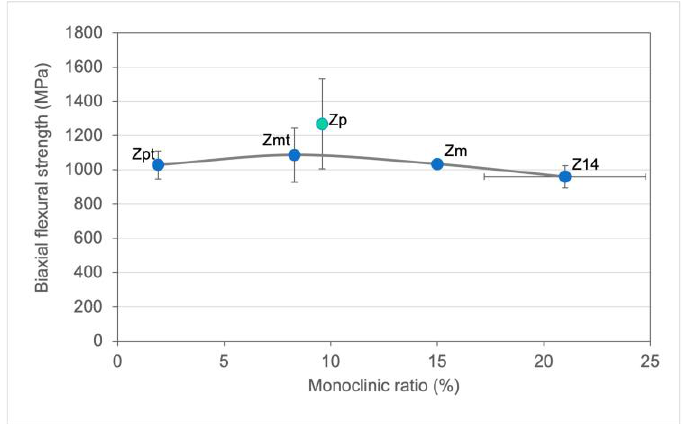
Figure 4. Biaxial flexural strength mean and standard deviations correlated to the monoclinic ratio of baseline samples that were obtained in a previous study [24].